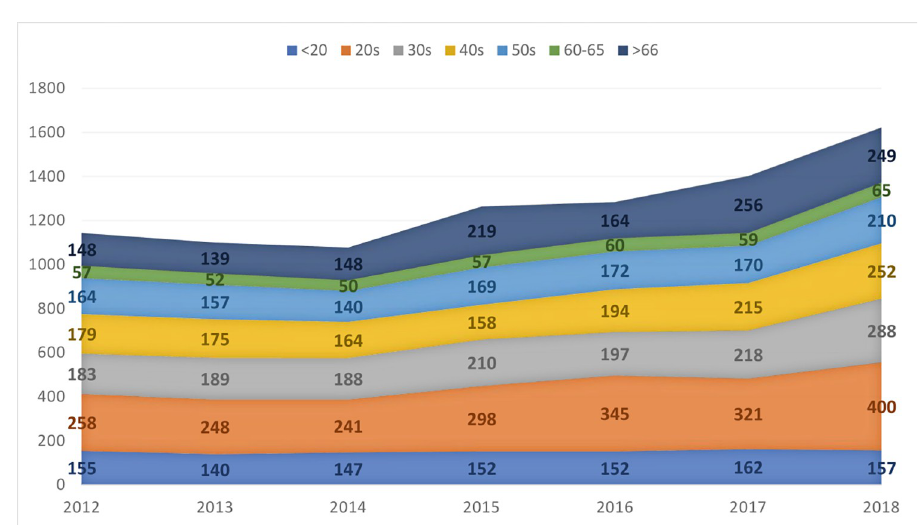
Fig 3. Analysis of occupational motorcycle injury according to year and victims’ age group.